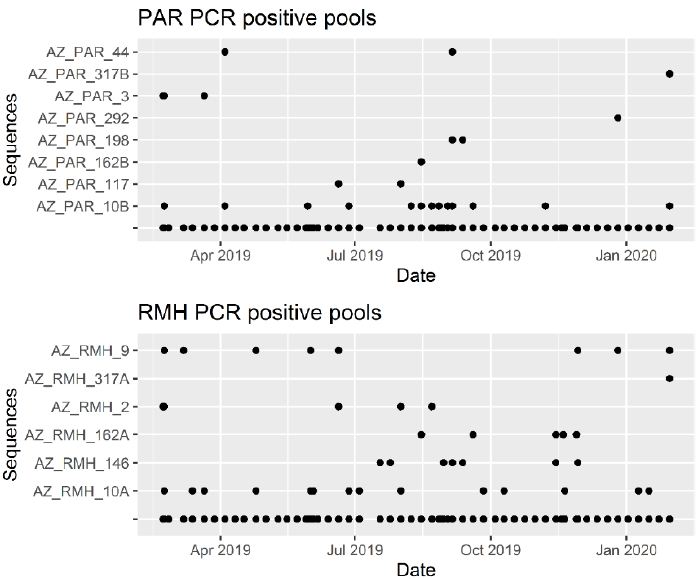
Figure 5. Detection of paramyxovirus RNA over time by the viral sequence. PAR = PCR with general paramyxovirus primers, RMH = PCR with Respirovirus-Morbillivirus-Henipavirus specific primers.